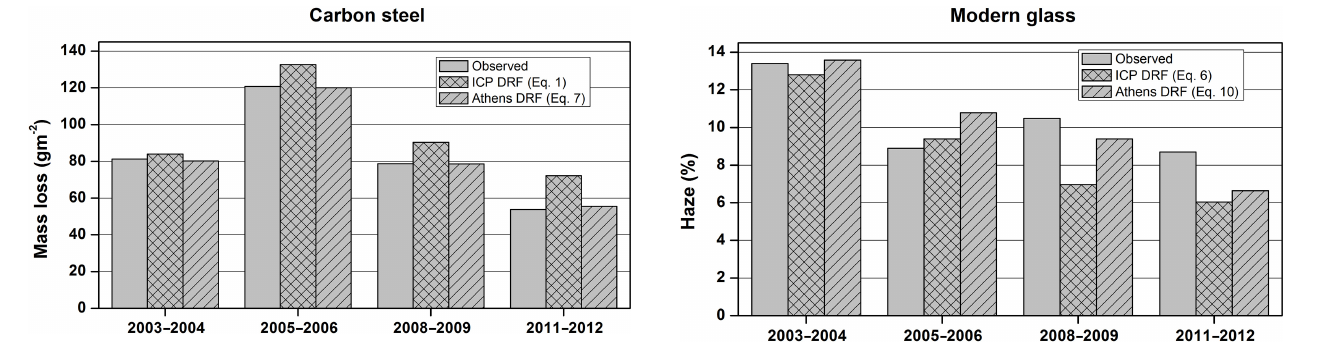
Figure 9. Experimental obtained mass loss values at Athens, Greece for the case of carbon steel along with the predicted values by DRFs.